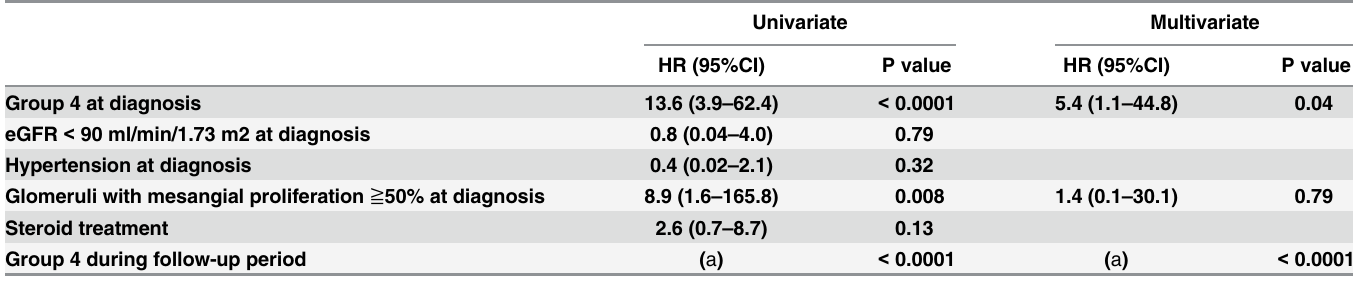
Table 2. Predicted risk factors for end-stage kidney disease.